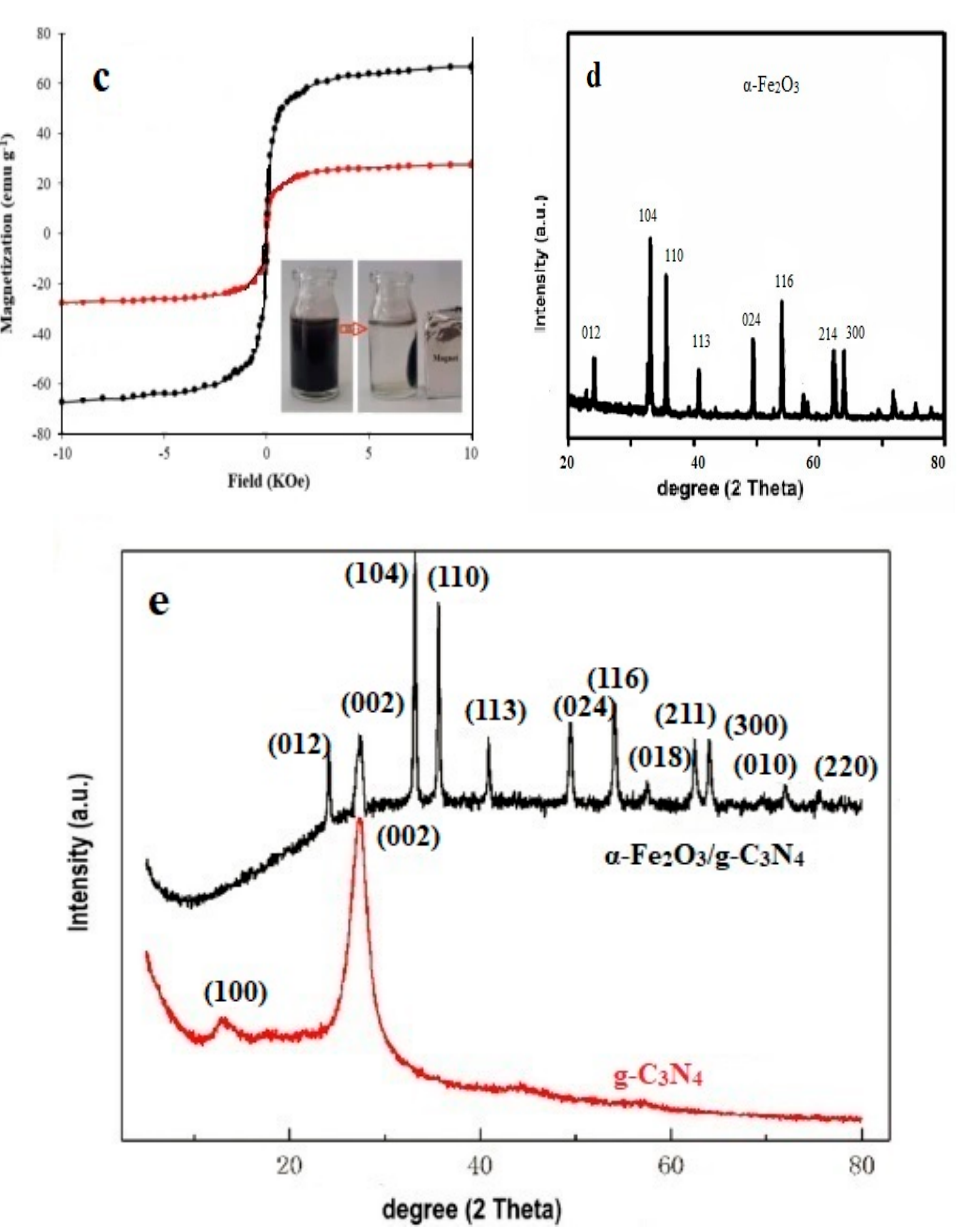
Figure 2. EDX patterns ( a ); IR spectra of g-C 3 N 4 and α -Fe 2 O 3 /g-C 3 N 4 ( b ); VSM patterns of α -Fe 2 O 3 and α -Fe 2 O 3 /g-C 3 N 4 ( c ); XRD patterns of α -Fe 2 O 3 ( d ); and g-C 3 N 4 and α -Fe 2 O 3 /g-C 3 N 4 ( e ).